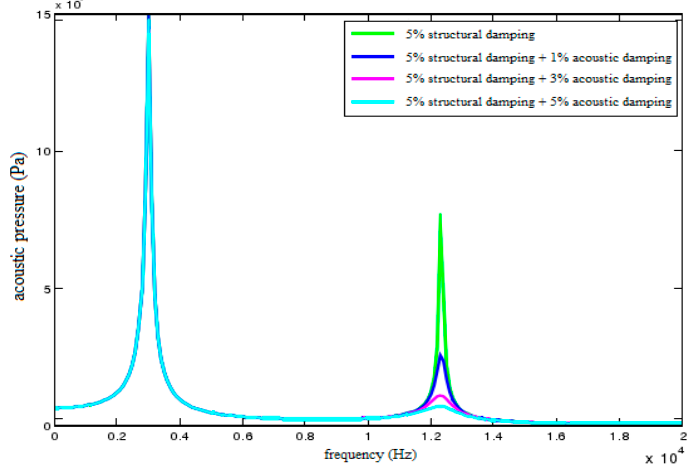
Figure 12. Acoustic pressure characteristic curves of field point A under different acoustic dampings.